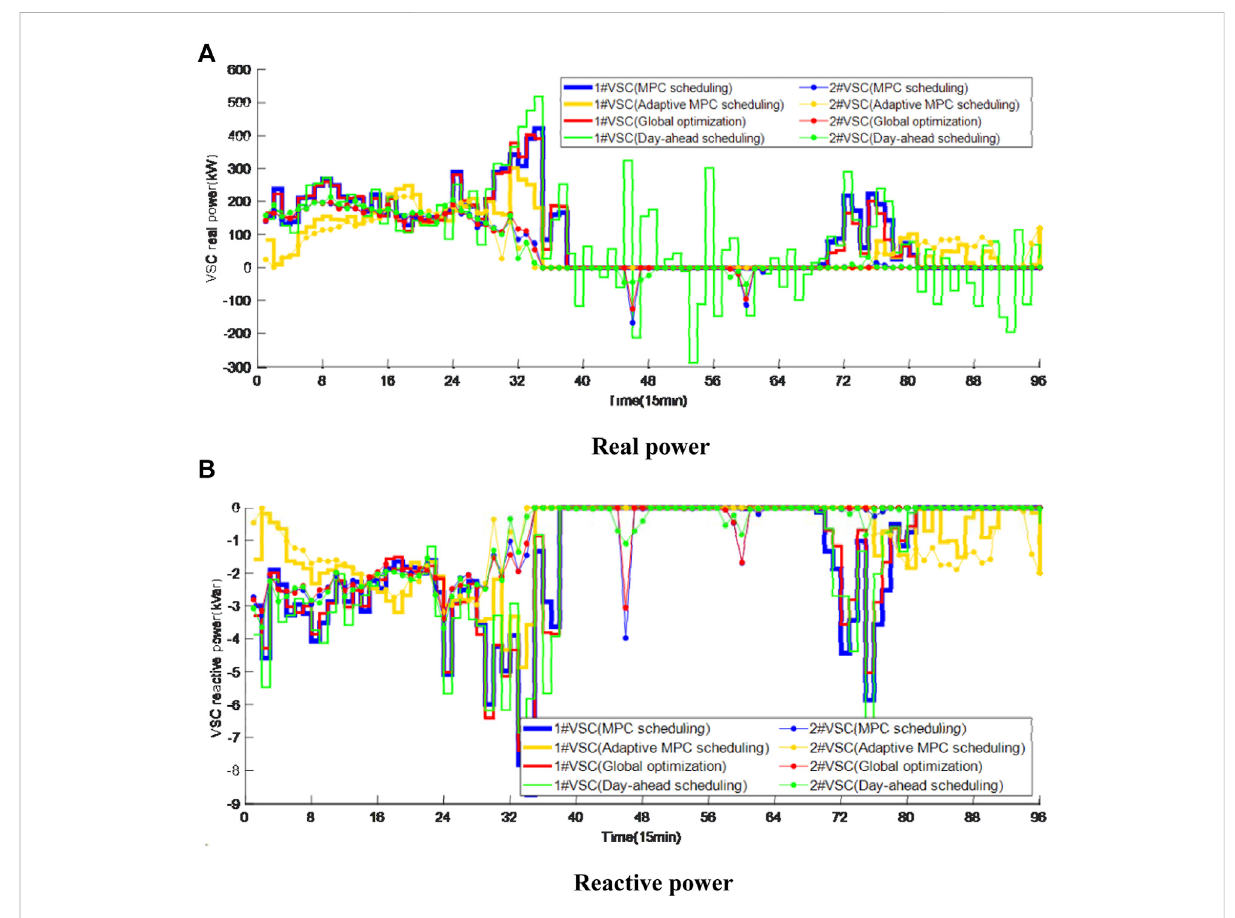
FIGURE 12 Power curves of the VSCs under different scheduling strategies. (A) Real power. (B) Reactive